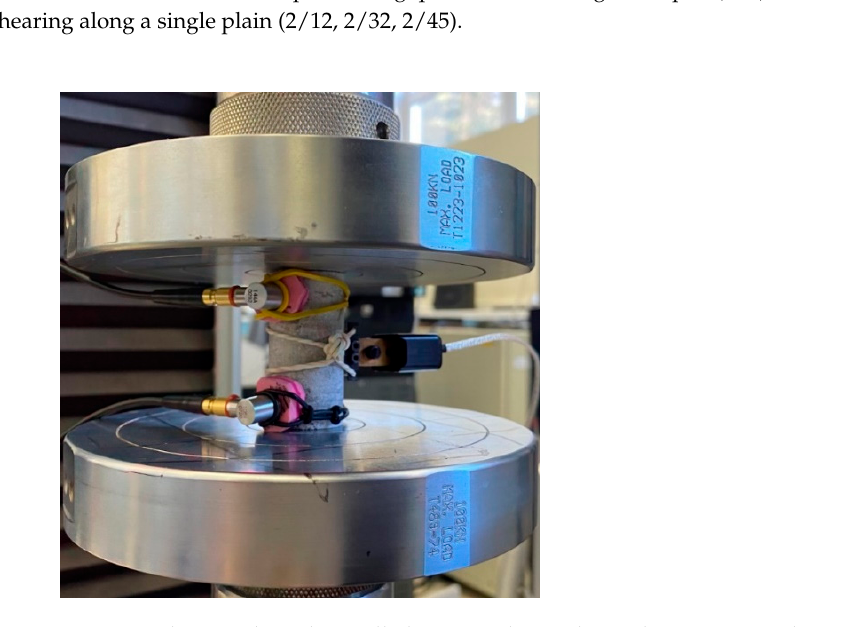
Figure 10. The sample with installed AETs and a mechanical extensometer between loading